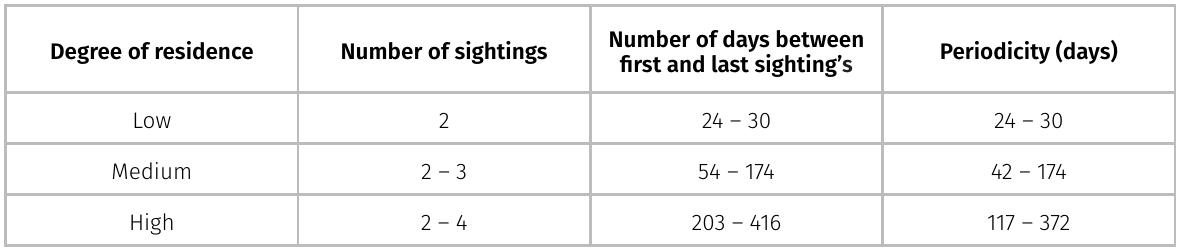
Table II . Reference numbers used for each measurement according to each degree of residence for common bottlenose dolphins, Tursiops truncatus truncatus , in Cabo Frio, RJ, Brazil.